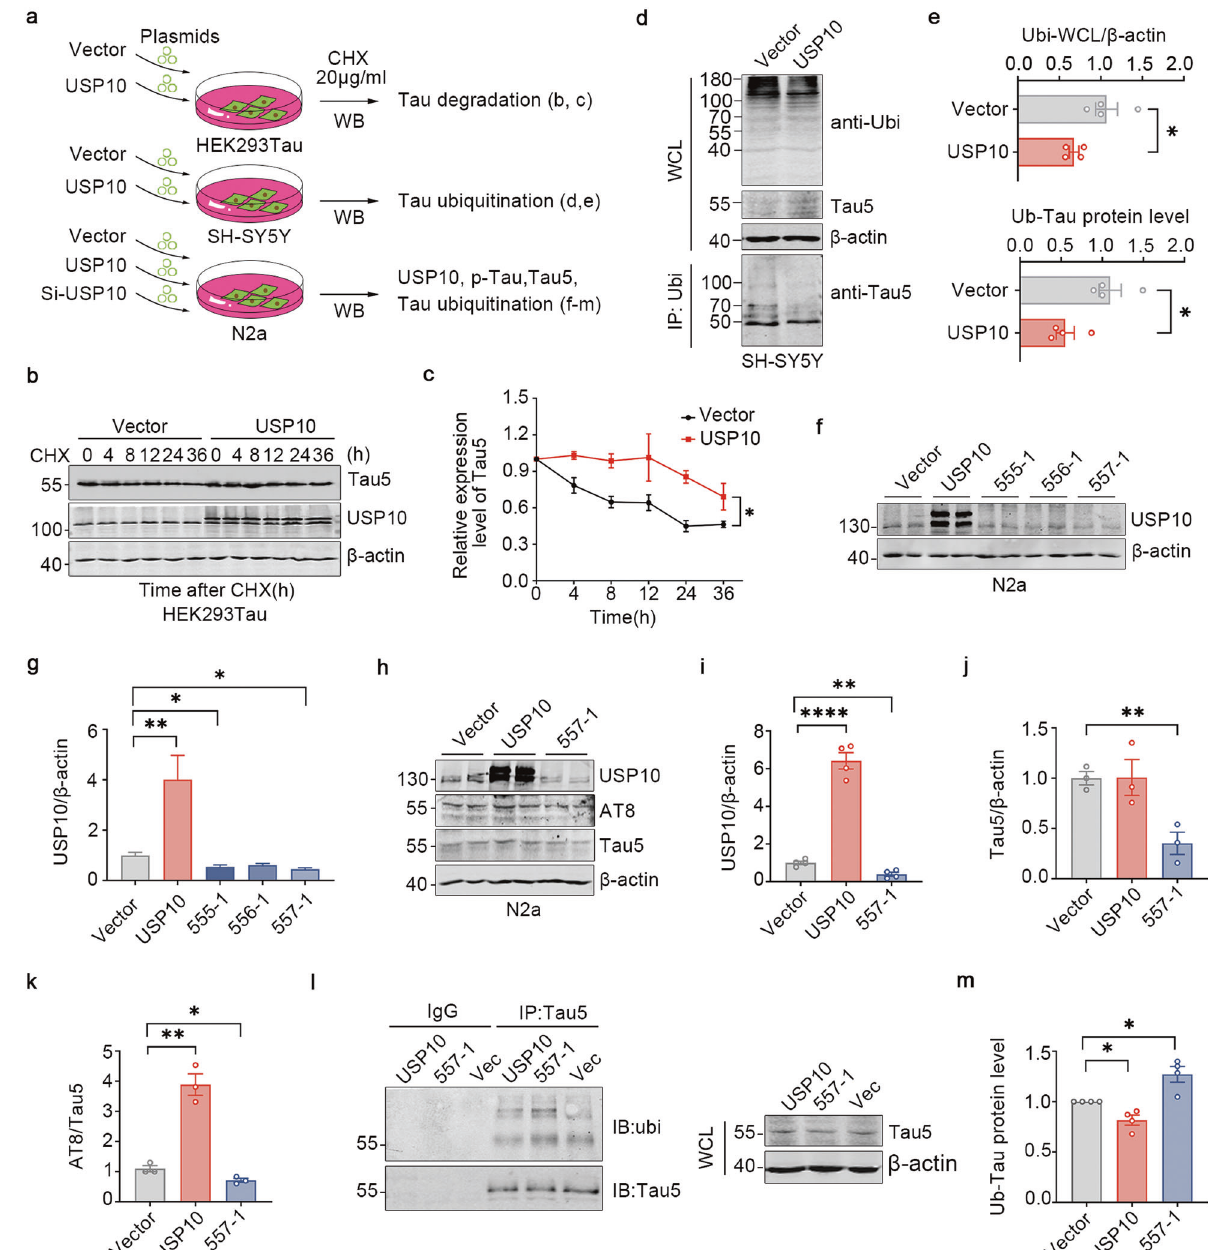
Fig. 4 USP10 promotes Tau stability by slowing down its turnover. a A Schematics of the experimental design. b HEK293Tau cells were transfected with USP10 plasmids for 6 h, followed by treatment with cycloheximide (CHX, 20 μ g/ml) for the indicated times to inhibit protein synthesis, and then analyzed by immunoblotting. c Quanti fi cation of the b blots, n = 3, p -value signi fi cance is calculated from a two-way ANOVA. d SH-SY5Y overexpressed with USP10 for 48 h, ubi was immunoprecipitated with anti-ubi polyclonal antibodies and then immunoblotted with monoclonal anti-Tau5 antibody. e Graph showing the normalized protein levels of ubiquitin of Tau and total protein; n = 4, p -value signi fi cance is calculated from a two-tailed t-test compared with vector. f , g N2a cells were transfected with the indicated siRNAs of USP10 for 48 h and the regulation of USP10 levels by the plasmids was evaluated. h N2a cells lysates expressing vector, USP10-OE, or USP10 siRNA plasmids were extracted. The panels show immunoblots of USP10, AT8, and Tau5. i – k Quanti fi cation of the relative USP10 and Tau5 protein levels are normalized to β -actin, relative AT8 level is normalized to Tau5. l , m USP10 regulated the ubiquitination of Tau as detected by IP in N2a cells. Anti-Tau5 immunoprecipates and WCL were analyzed using western blotting. p -value signi fi cance is calculated from a two-tailed t-test compared with vector, * P < 0.05, ** P < 0.01, **** P < 0.0001. WCL, whole cells lysates. neurons with 50 μ M of either Tau307-326K + Tau341-378K or glutamine (Q), lost their ability to reverse Tau upregulation Tau307-326Q + Tau341-378Q and then incubated them with (Fig. 6e – h). A β 42 oligomers for 24 h. CCK8 assay showed there was no The above results postulate that USP10 is involved in Tau pathology induced by A β . To explore the possible effect of obvious toxicity for primary neurons as above treatment interfering peptides in the A β toxicity setting, we incubated Cell Death and Disease (2022)